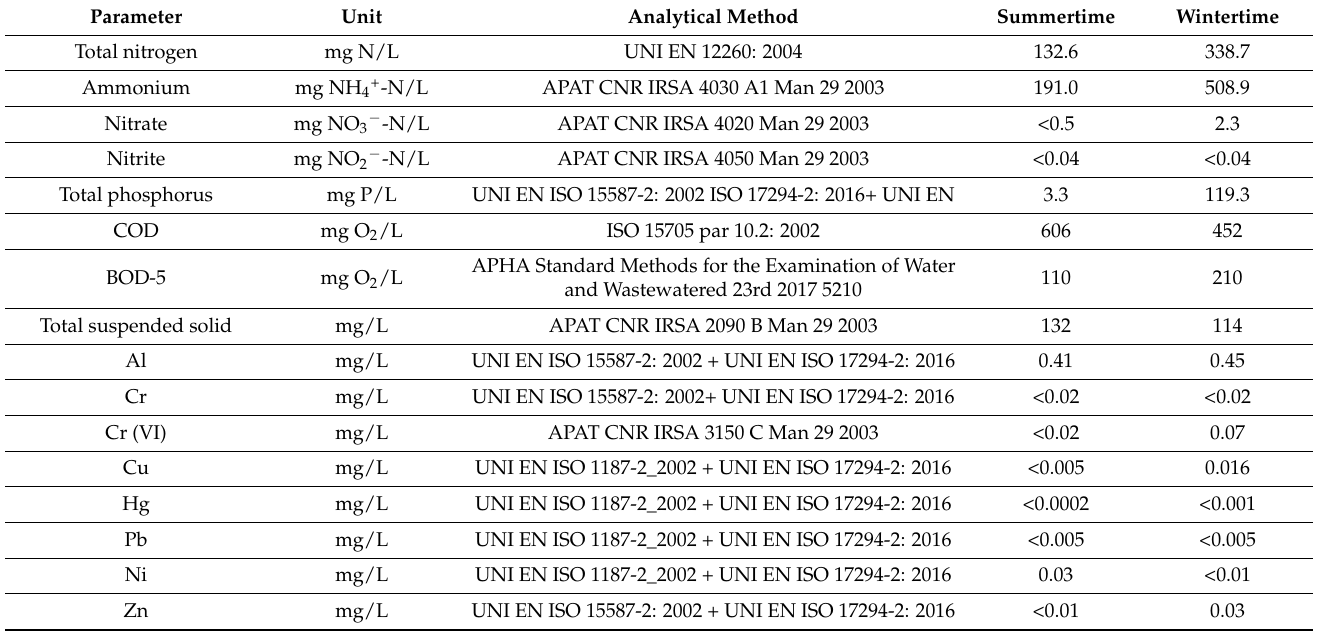
Figure 9. Centrate collected at the HERA-Ferrara wastewater treatment plant after the dewatering process of the digested sludge. ( a ) Centrate stream collected in summertime; ( b , c ) Centrate stream collected in wintertime before ( b ) and after ( c ) filtration. Table 1. Characterization of the centrate streams sampled during summertime (July 2019) and in wintertime (January 2020). Analytical methods employed for each analysis and measurements units are also reported. N to P molar ratio was about 128 and 9.5 in summer and winter samples,